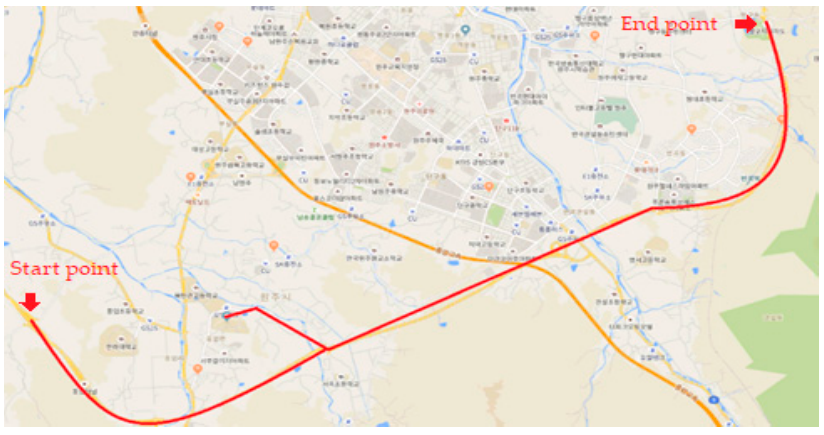
Figure 2. Driving map for vehicles.